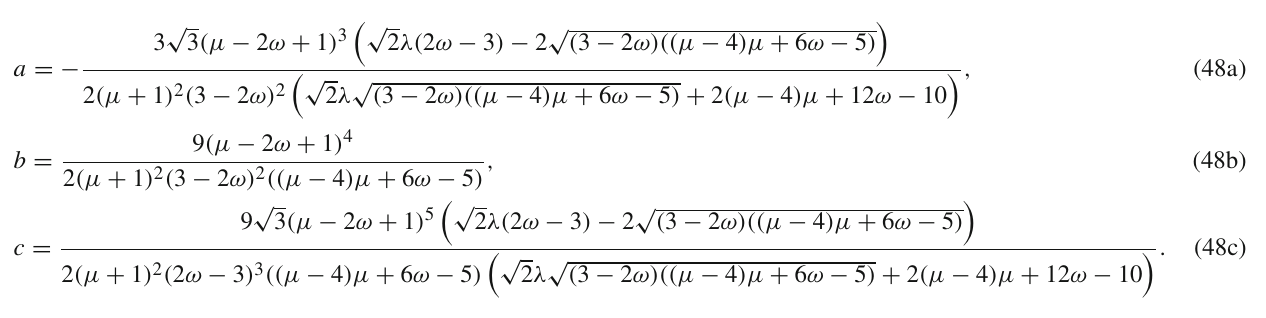
of ( u , v) given by (45) for ω = 0. The solid red lines denote √ the implicit function 6 x ( u ) + y ( u , v) 2 + 1 = 0, with x ( u ) and y ( u , v) defined by (44) for ω = 0, whereas the dashed black lines represent the approximated center manifold of C − . Let us observe the accuracy for small u